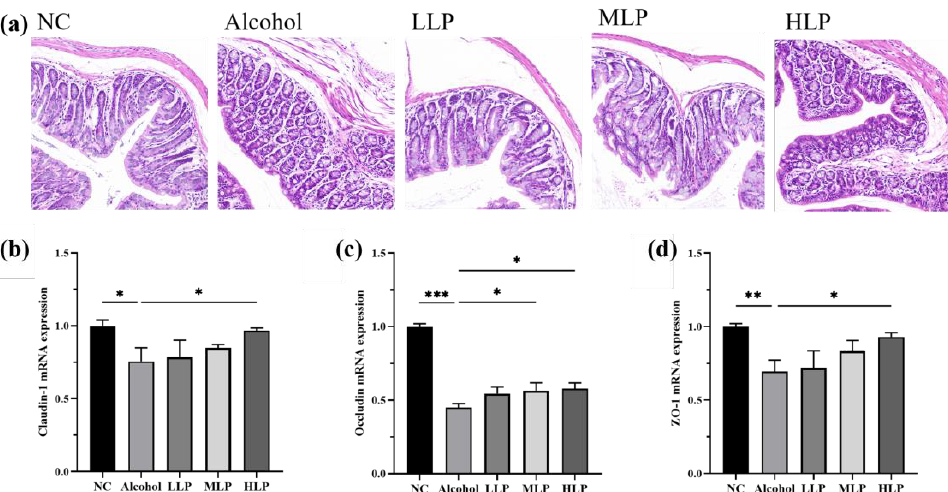
Figure 8. Effects of L. plantarum J26 on alcohol-induced intestinal injury in mice. ( a ): (H&E staining, magnification × 20; ( b ): gene expression of Claudin-1; ( c ): gene expression of Occludin; ( d ): gene expression of ZO-1. ZO-1, zonula occludens-1; NC, normal control; LLP, low-dose L. plantarum J26; MLP, medium-dose L. plantarum J26; HLP, high-dose L. plantarum J26. The data were analyzed with a one-way ANOVA and expressed as means ± SD ( n = 6). * p < 0.05, ** p < 0.01 and *** p < 0.001 compared with the Alcohol